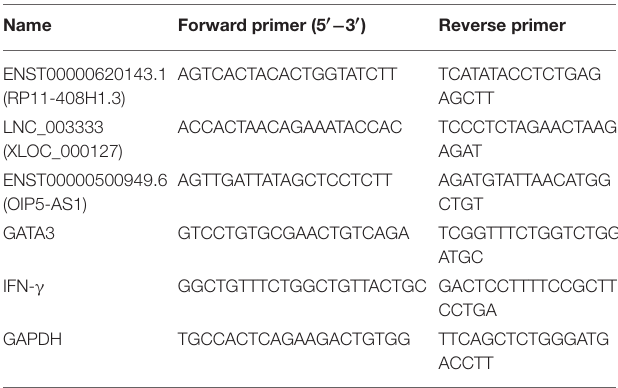
TABLE 2 | Primers used to validate gene